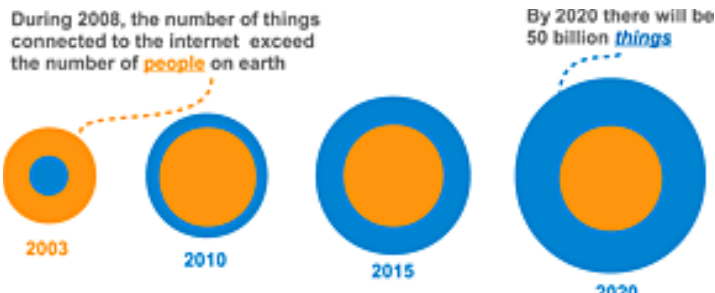
Figure 1. Increase the number of objects connected to the Internet